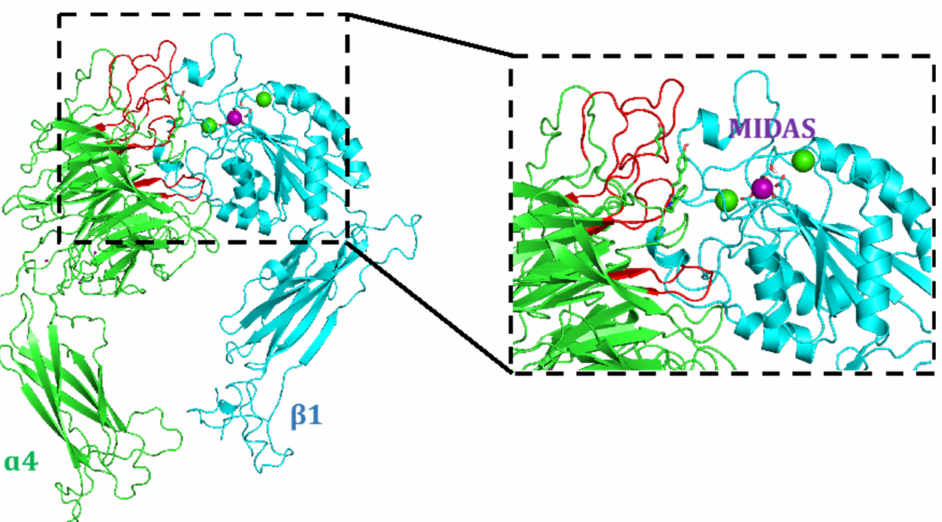
Figure 3. The developed α 4 β 1 complex shows the classical structural organization of the integrin family; α 4 subunit (green cartoon), β 1 subunit (cyan cartoon); the Ca 2+ and Mg 2+ ions of MIDAS are depicted as green and purple spheres, respectively. The portion of the β -propeller domain ( α 4 subunit) involved in ligand binding region is evidenced in